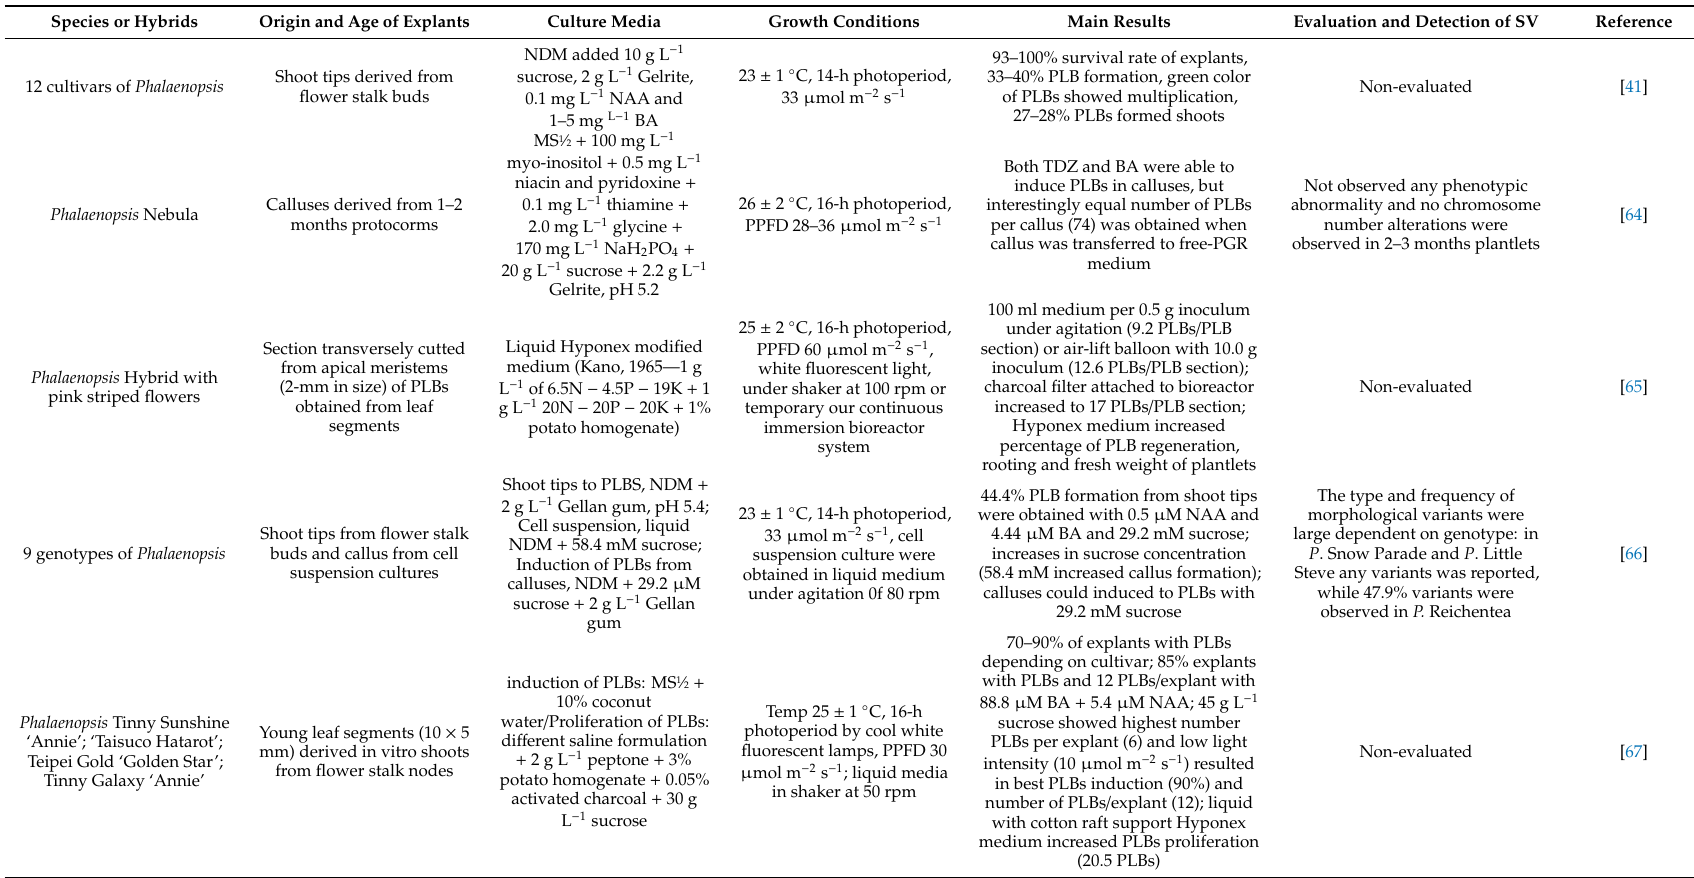
Table 1. Compliance of studies with induction, proliferation and regeneration of PLBs (IPR-PLBs) with Phalaenopsis and Doritaenopsis